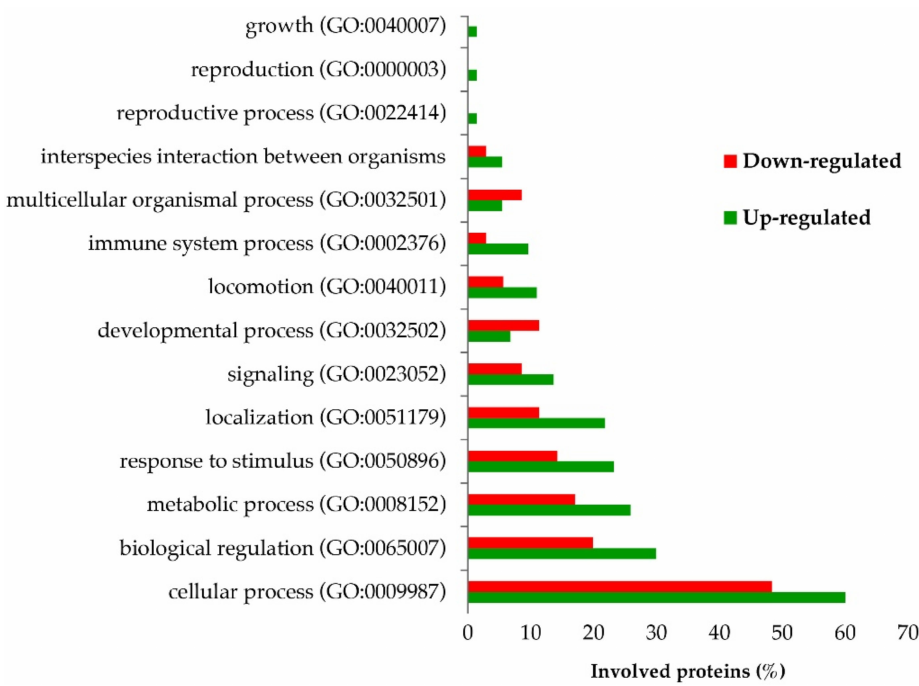
Figure 4. Gene ontology of differentially regulated proteins. Panther Classification System was used to analyze the identified proteins based on their involvement in biological